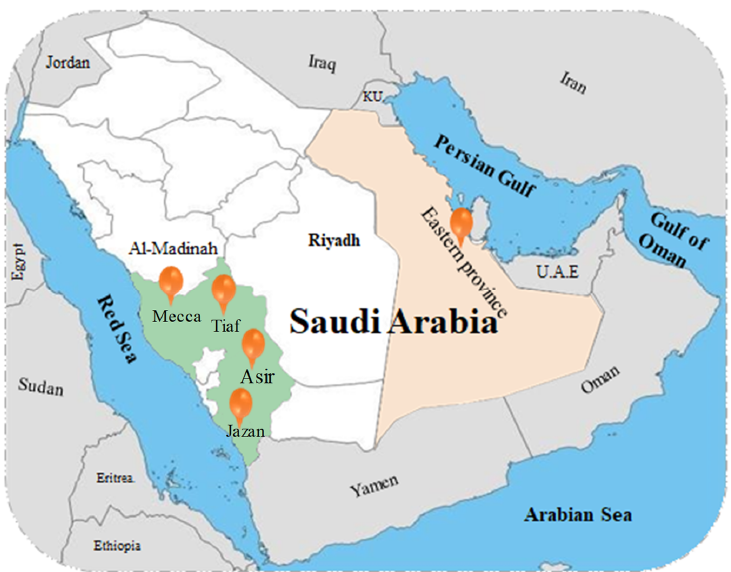
Figure 1. A map showing the surveys sites of different ecological areas in Saudi Arabia (SA).